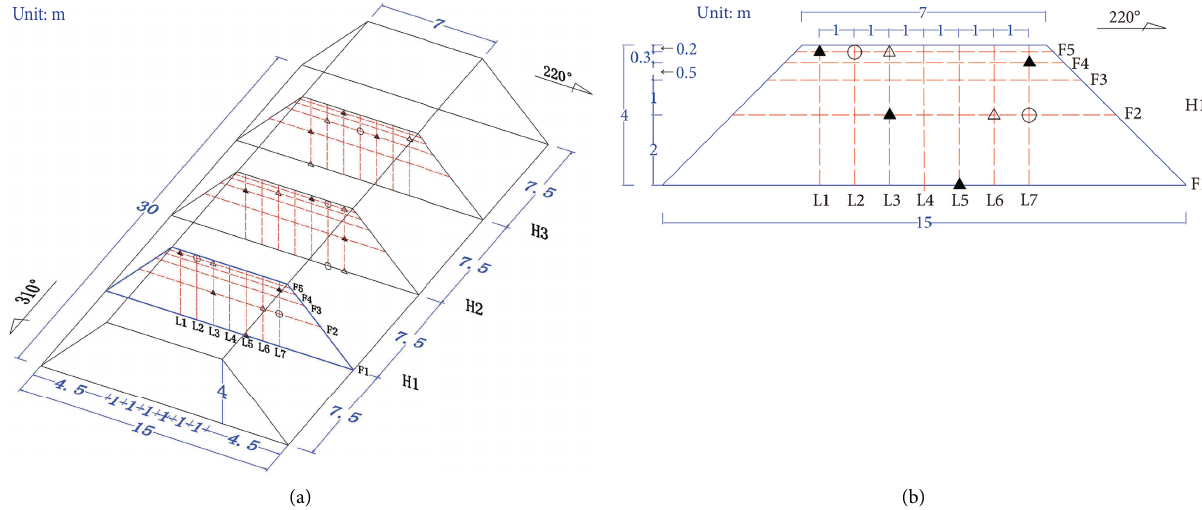
Figure 4: Schematic of the size of a single section of the aeolian sand-modified soil test roadbed and the location of the sensors. (a) Three- dimensional spatially diagram of the embedded sensor nodes and (b) position of the five horizontal planes and seven longitudinal